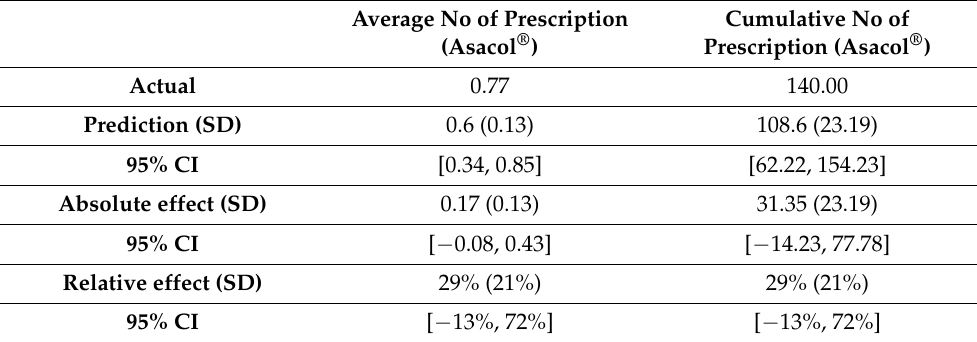
Table 1. Summary statistics—Causal Impact Analysis (pre-intervention 1 vs. intervention 1) for Asacol ® . Average No of Prescription Cumulative No (Asacol ® )